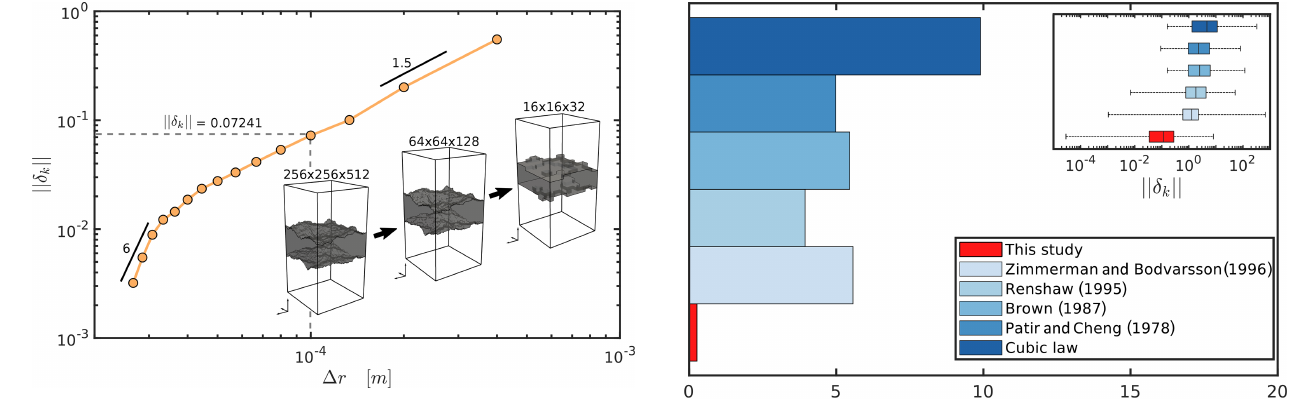
Figure 8. Error norm computed by Eq. (18) as a function numerical voxel size (cid:49)r . The orange line depicts the mean error of 128 dif- ferent fracture subsets discretized with decreasing resolutions. The figure inlay sketches the downsampling procedure: the maximal res- olution is consecutively decreased by 16 voxels in the horizontal and 32 voxels in the vertical direction (displayed are the maximal, intermediate, and minimal reduction stages). Dashed gray lines in- dicate the voxel size and associated error norm of the numerical simulations used to provide the refined single-fracture permeabil- ity parameterization. Black lines highlight the convergence rate by showing local slopes as indicated by the attached values.